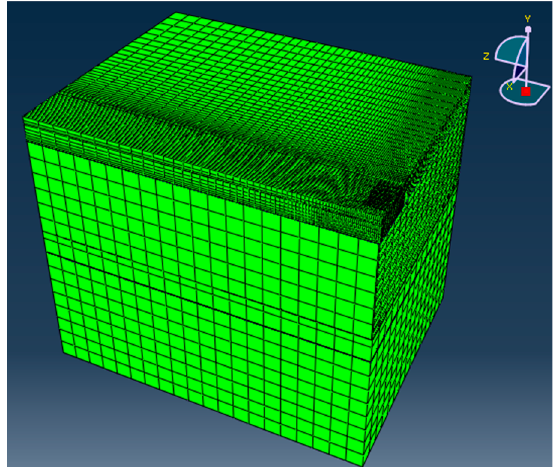
Figure 5. The geometry and meshing result of the finite element model utilized in the study.